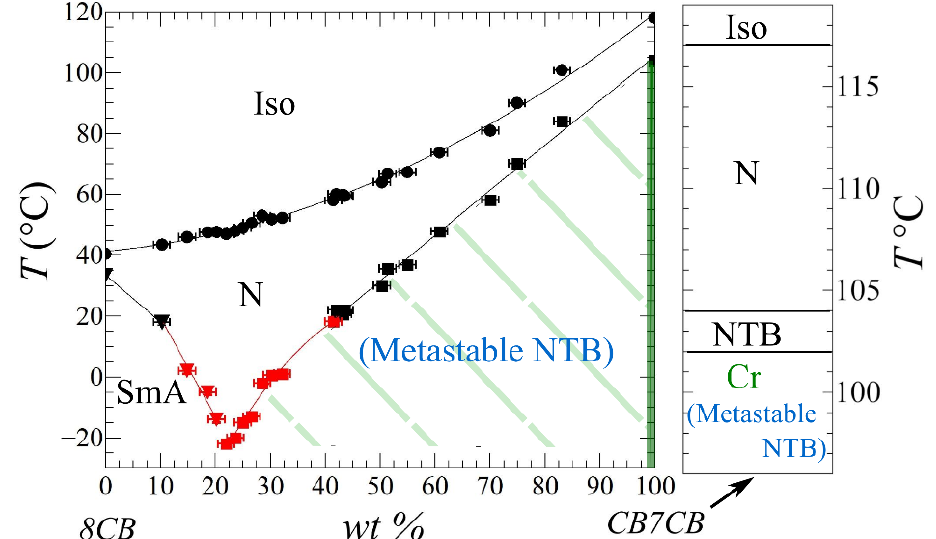
Figure 2. Phase diagram of 8CB / CB7CB binary system. The phase transition temperatures were obtained either by (POM) (black symbols) or dielectric measurements (red symbols). The nature of the lower temperature phase was confirmed using XRD. The green line indicates the stable crystalline state of CB7CB. N TB phase is metastable almost everywhere, except possibly a few degrees below the N / N TB phase transition. The thermodynamically stable state of green dashed region is a two phase equilibrium between crystalline CB7CB and either N TB in the high temperature corner or N phase at lower temperatures (see main text). Error bars are mainly due to uncertainty in the concentration of small-quantity samples. They correspond to the data dispersion of the phase transition temperatures.